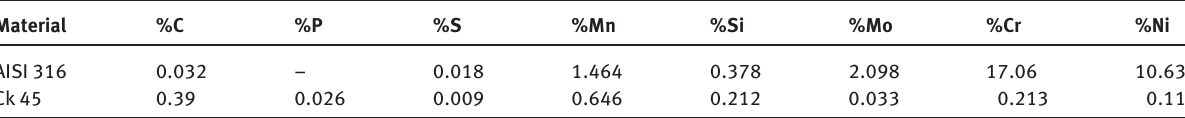
Table 1: The chemical composition of the AISI 316 and Ck 45 steels (mass%) Material